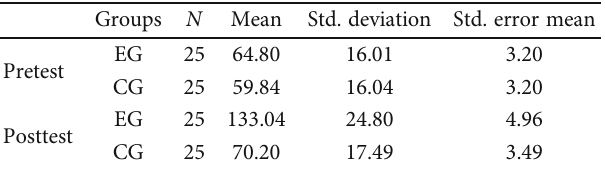
Table 8: Descriptive statistics of both groups in the anxiety pretests and